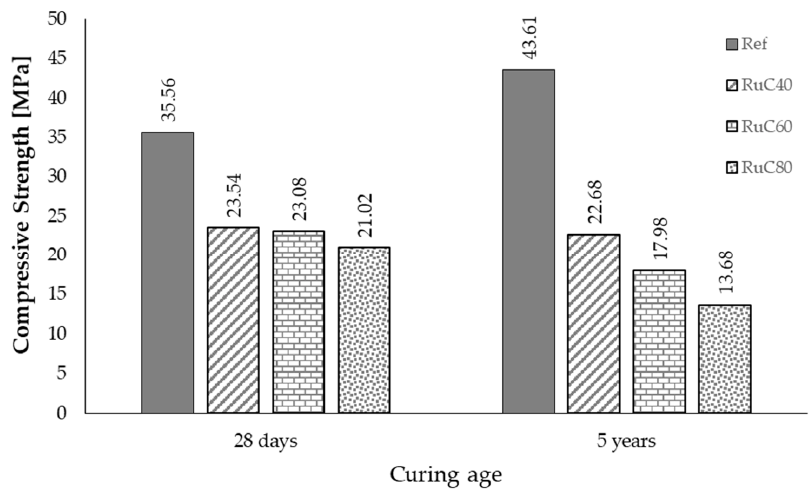
Figure 12. Compressive strength of Ref and RuC mixes.